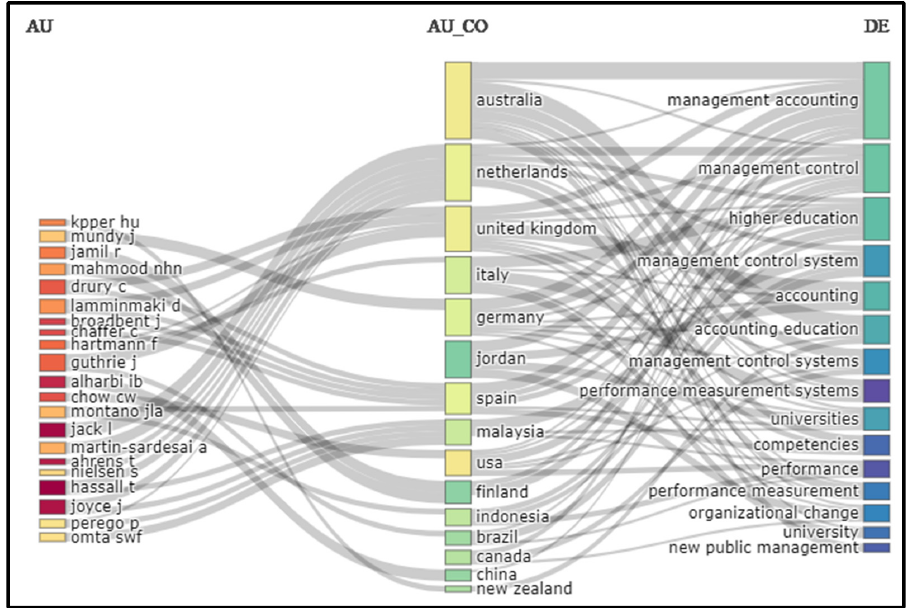
Figure 5. Main research fields.